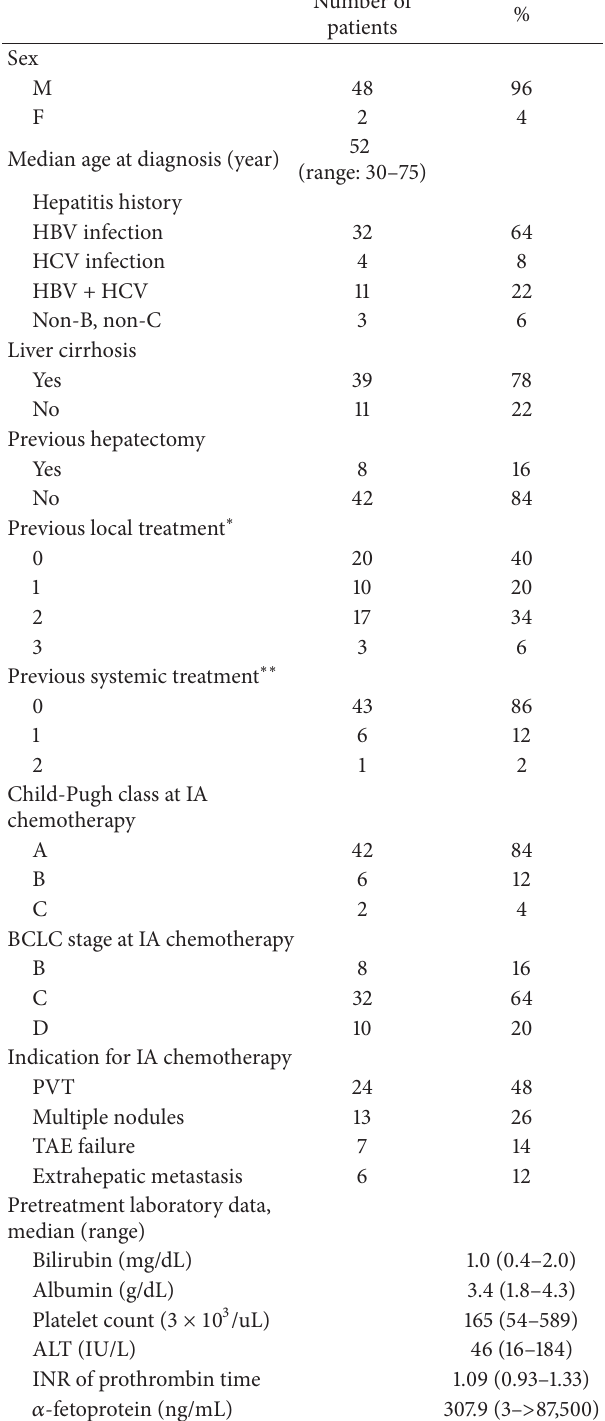
Table 1: Baseline clinical characteristics of